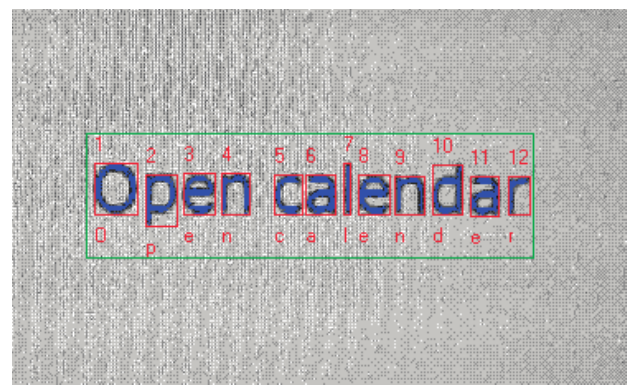
Figure 15. Recognition result.